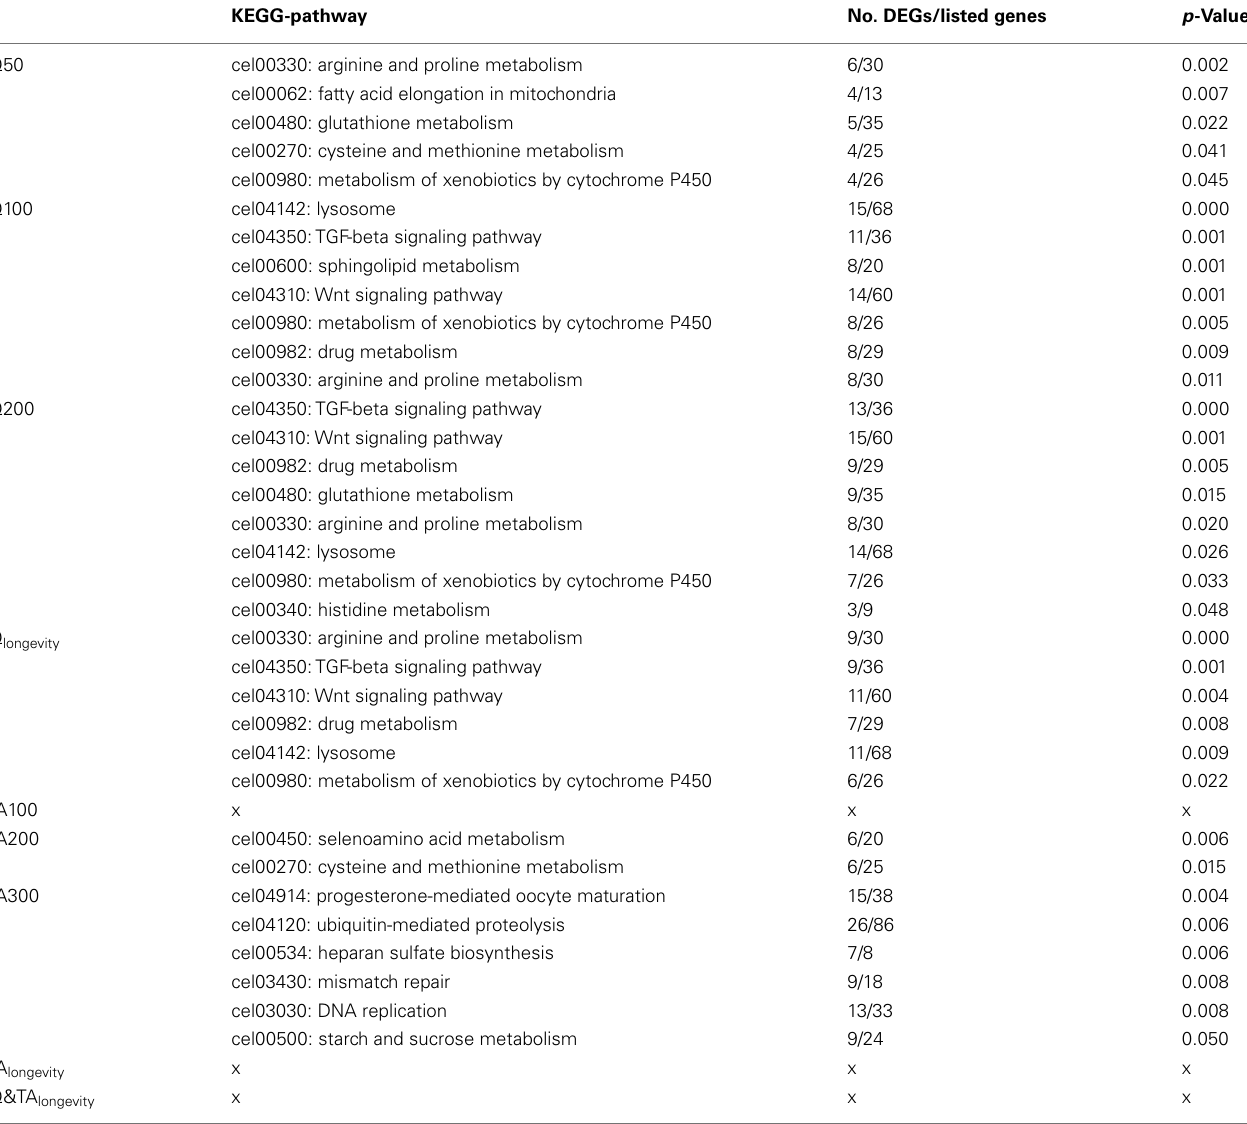
Table 1 | Overview of significant KEGG-pathways (seeTable S3 in Supplementary Material 1 for pooled groups and Supplementary Material 4: sheet “KEGG-Analysis” for genes with